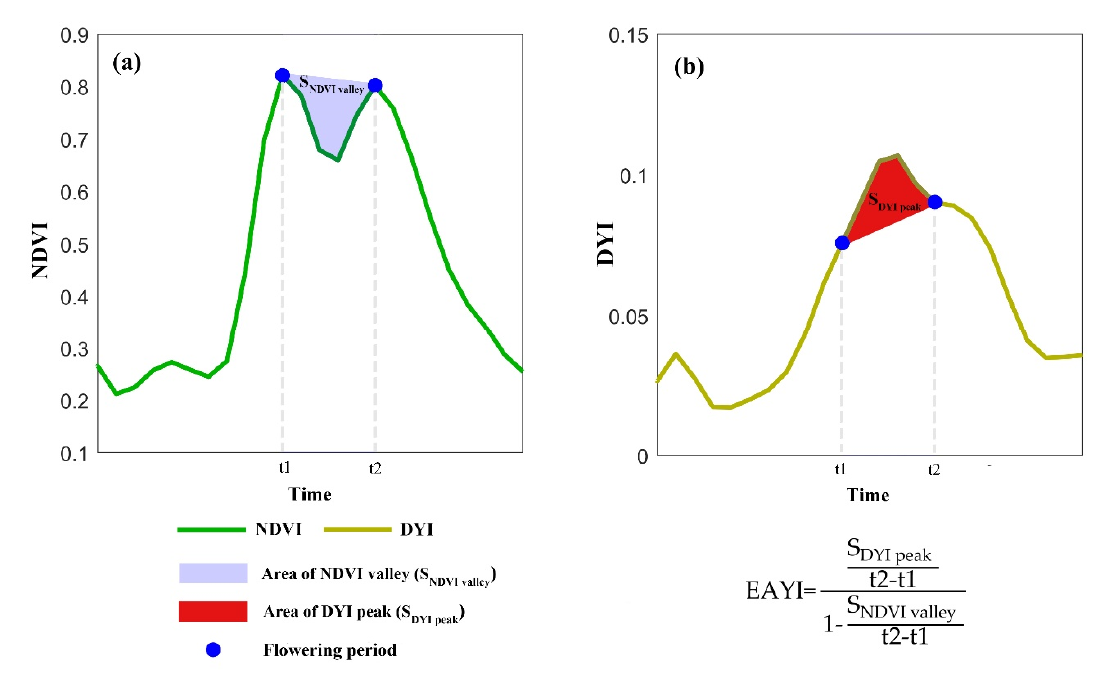
Figure 7. Illustration of EAYI calculation. ( a , b ) are the NDVI and DYI time-series of a canola pixel. The t1 and t2 are the beginning and end time of flowering period.